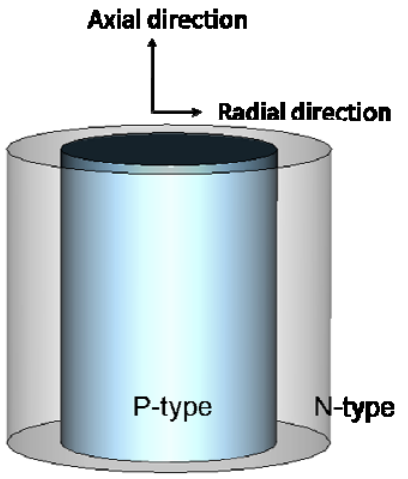
Figure 13. A scheme of a radial p-n junction structure. This structure allows the light absorption (axial direction) to be perpendicular to diffusion path (radial